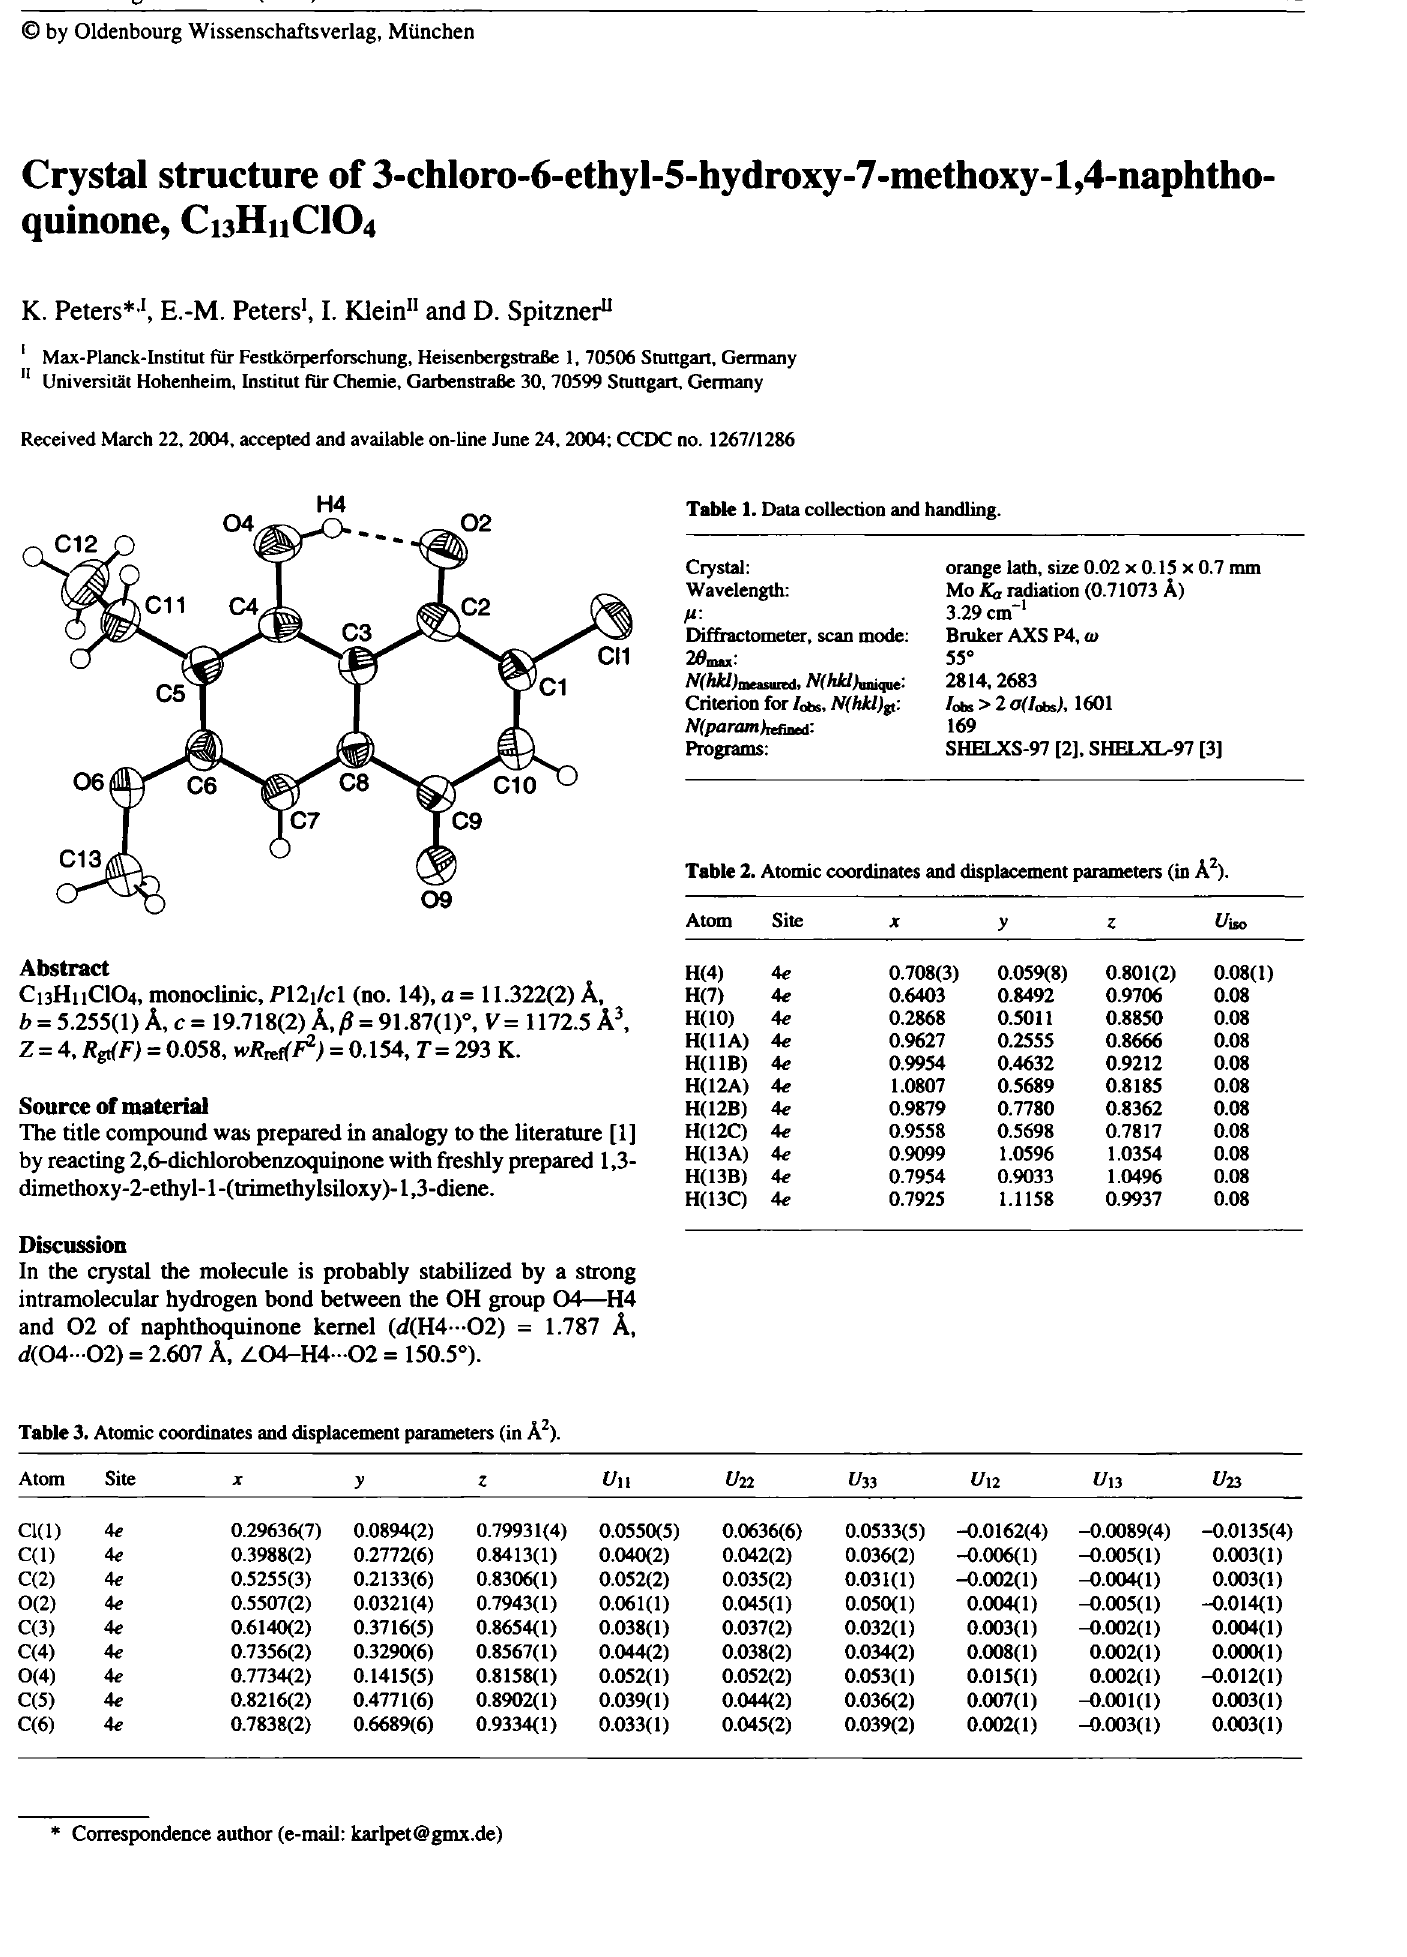
Table 3. Atomic coordinates and displacement parameters (in A 2